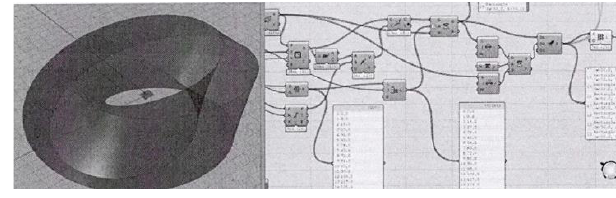
Figure 7: Modeling stage